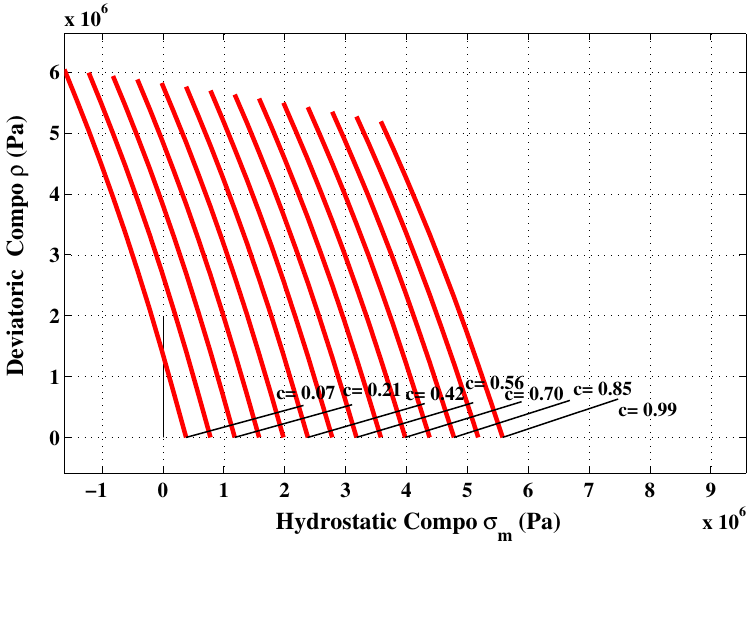
Figure 16. Softening stage in numerical triaxial tension